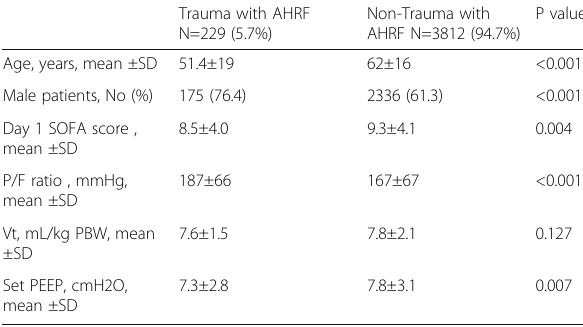
Table 4 (abstract A4). Characteristics of trauma patients in LUNG SAFE Trauma with AHRF N=229 (5.7%)